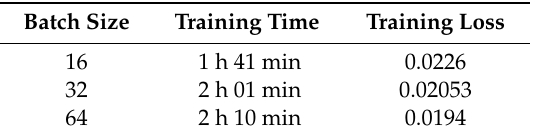
Table 4. Results of the comparison between di ff erent batch size.